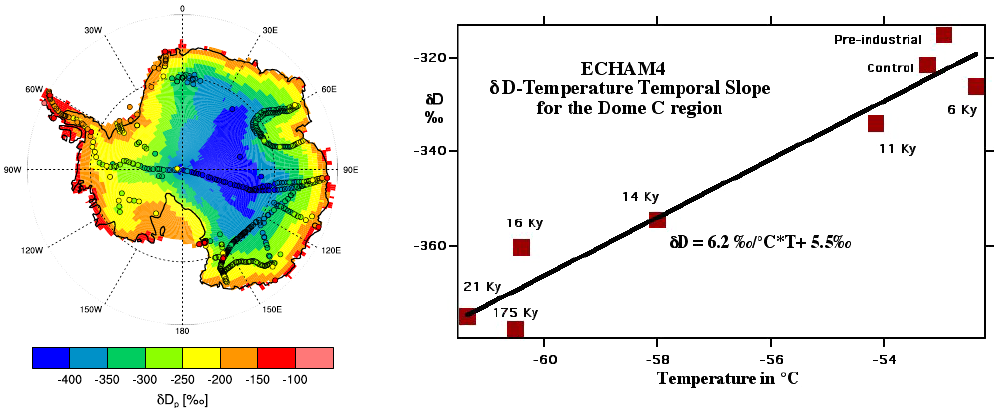
Fig. 8. Left panel: observed (coloured circles from a compilation by Masson-Delmotte et al., 2008) and simulated (ECHAM5-wiso with fine spatial T159L31) annual mean HDO values in precipitation ( δ Dp) for Antarctica (after Werner et al., 2011). Right panel: the temporal slope as derived from ECHAM 5 IGCM for the Dome C region (Jouzel et al.,